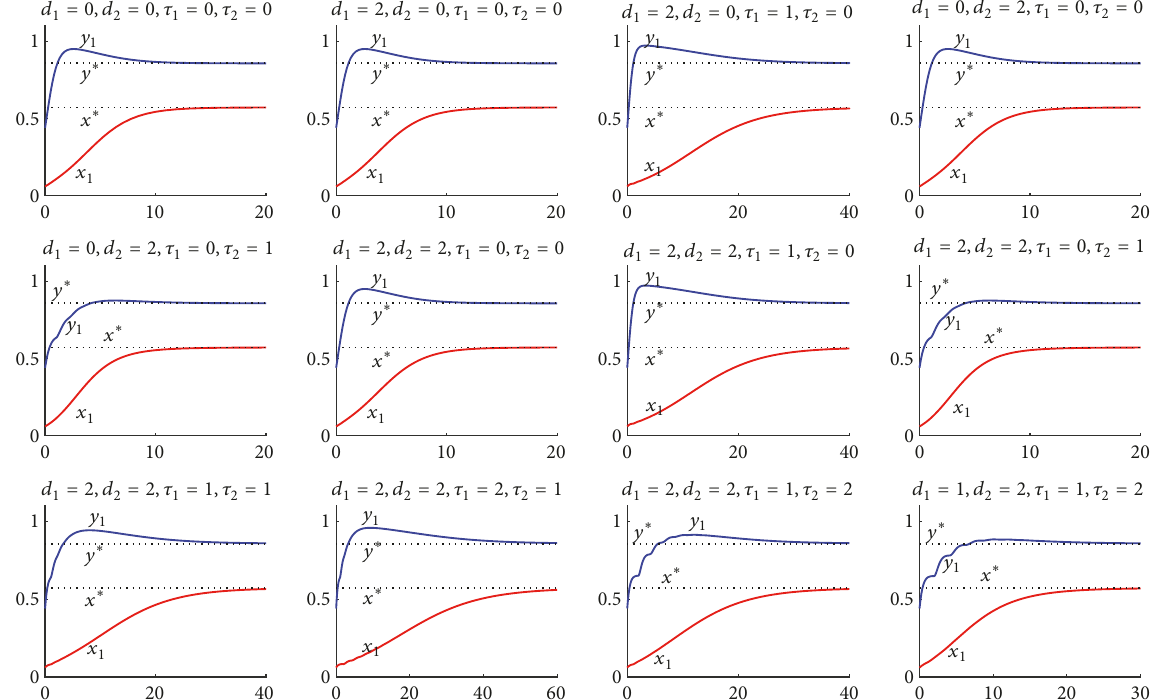
Figure 1: Numerical solutions of system (2) with parameter values 𝑎 = 0.5 , 𝑏 = 0.25 , 𝜌 = 2 . In this case, the symmetric coexistence equilibrium 𝐸 ∗ is locally asymptotically